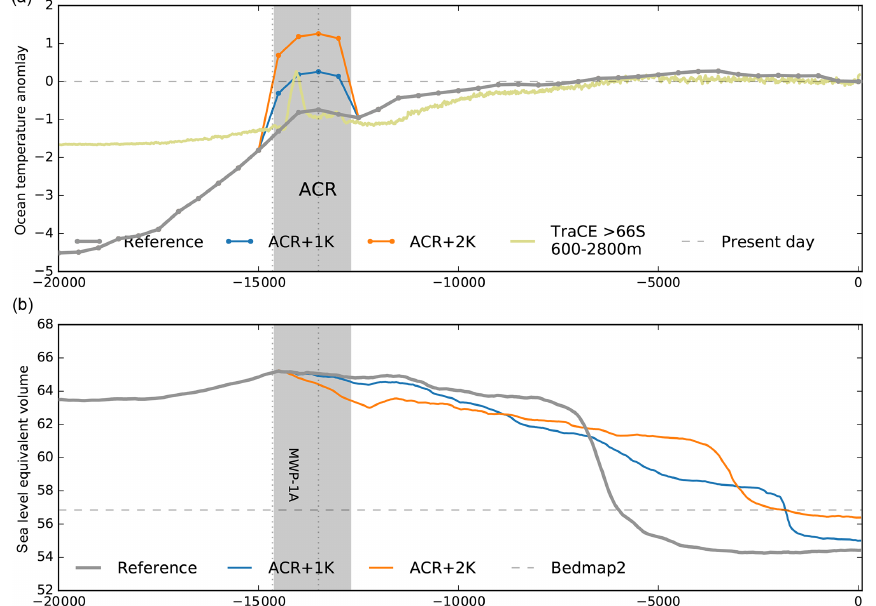
Figure A1. Simulation over two glacial cycles (only last 20kyr shown here) with different ocean temperature forcing, increased here by 1 or 2K in the 2-millennium phase (14.6–12.7kyrBP) of the ACR after MWP1a (a) . Within this range, for comparison, the reconstructed GCM ocean temperature data from TraCE-21ka are shown as average over 600–2800m depth and south of 66 ◦ S (green). The additional melt causes a doubling or even 6-fold increase in early ice volume losses, respectively, but most of the ice sheet retreat is somewhat delayed (b) .